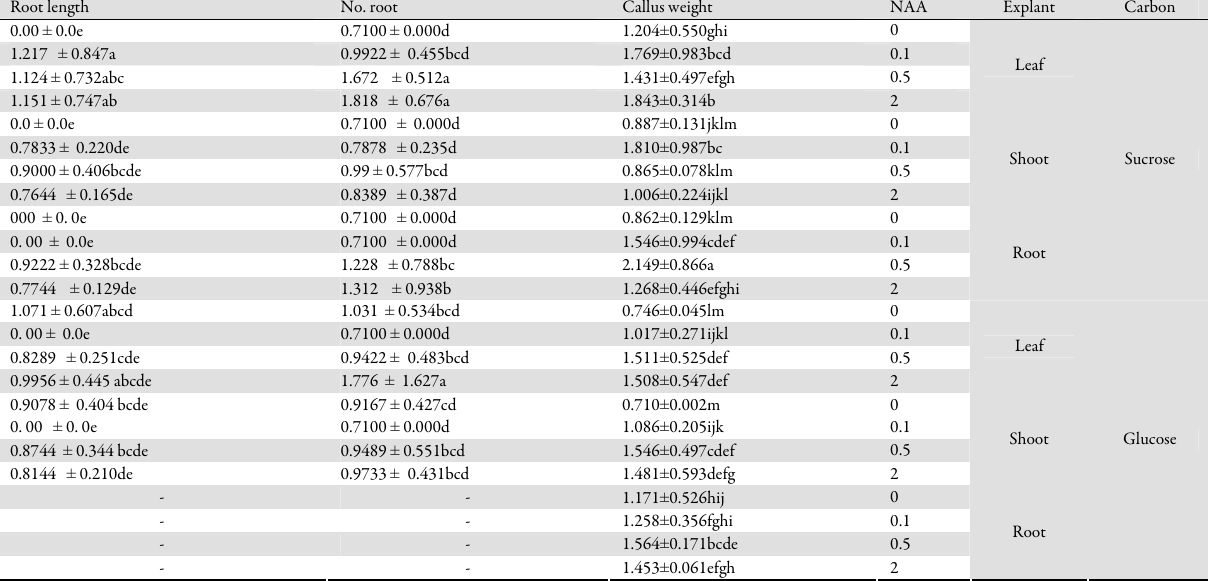
Table 12. The effect of interaction of NAA, carbon and explant on callus and root induction of A . annua on MS medium Root